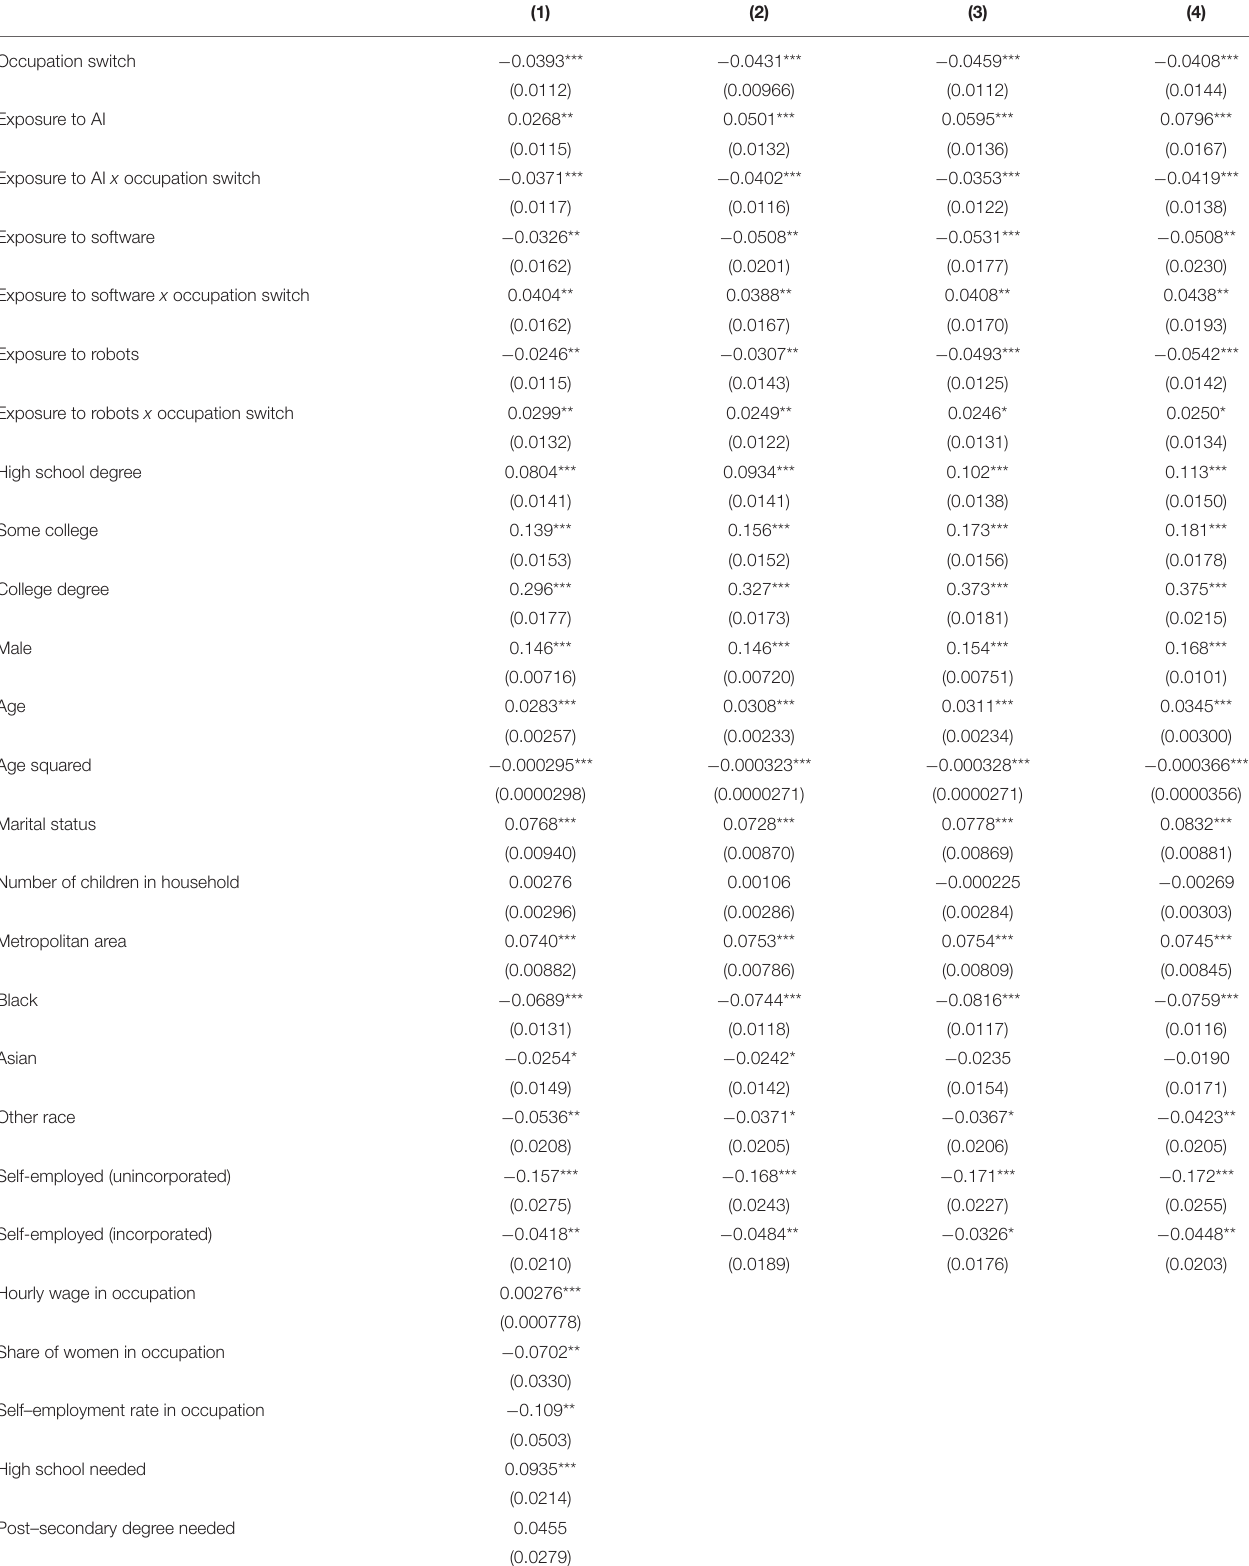
TABLE 2 | Relationship of technology exposure with annual wage growth